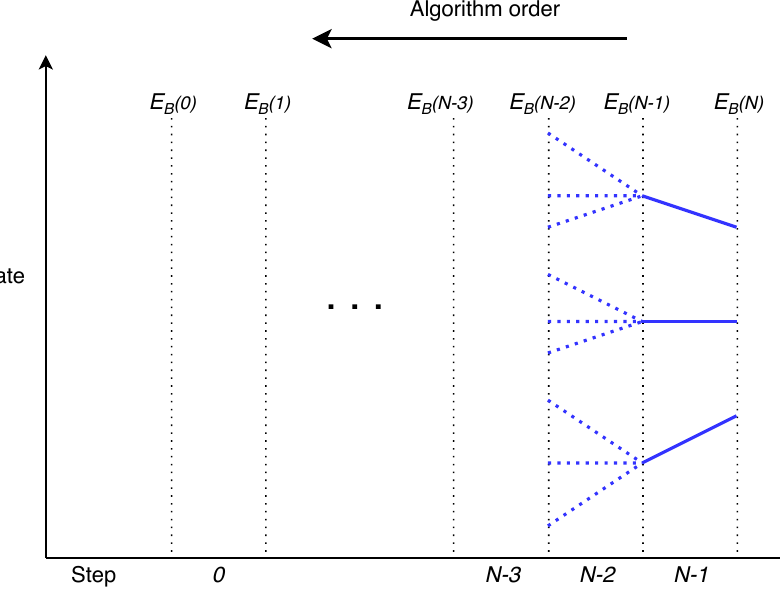
Figure 4. Dynamic programming